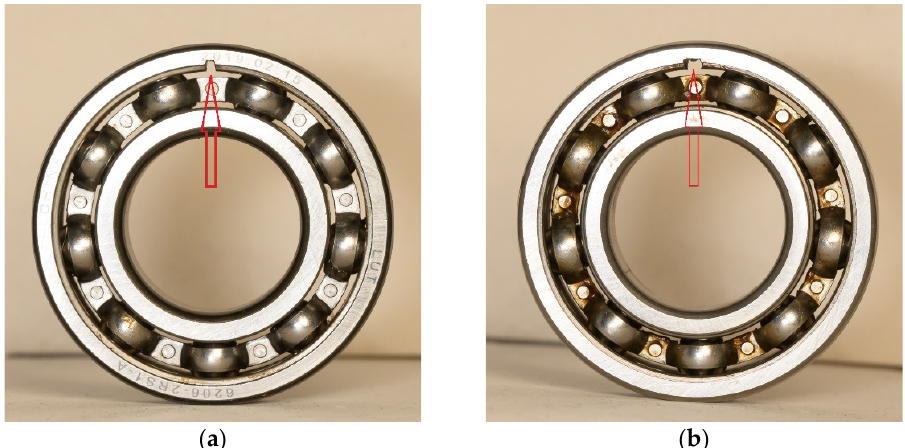
Table 3. Structural parameters of tested bearings.